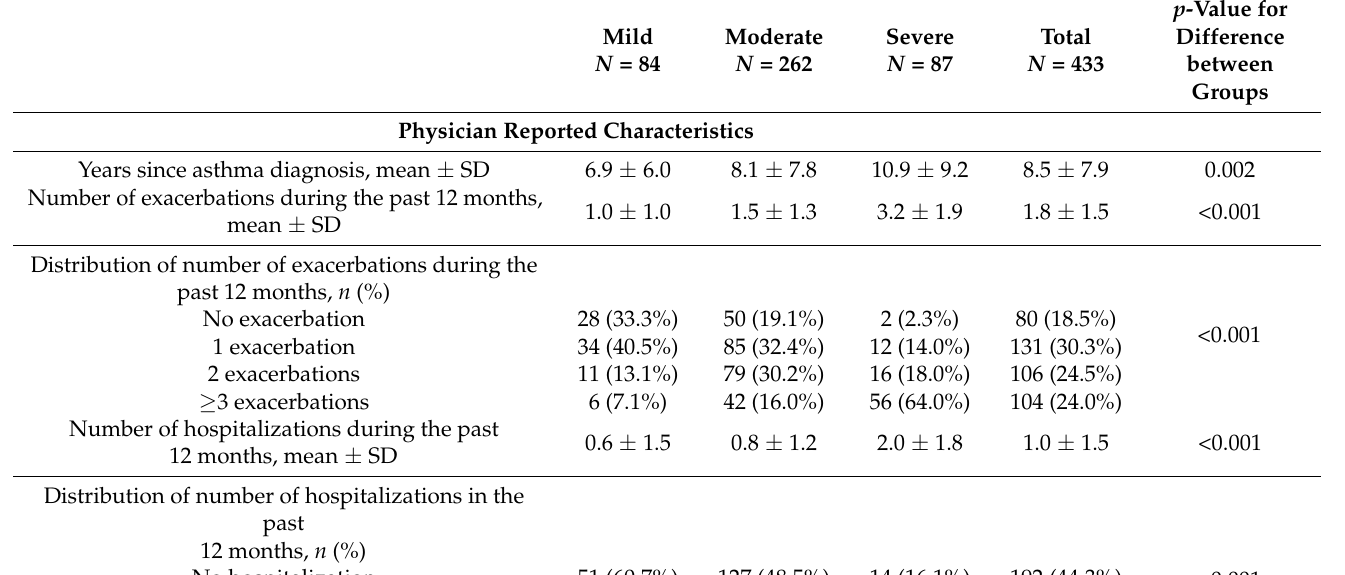
p -Value for Difference Mild Moderate Severe Total N = 84 N = 262 N = 87 N = 433 between Groups